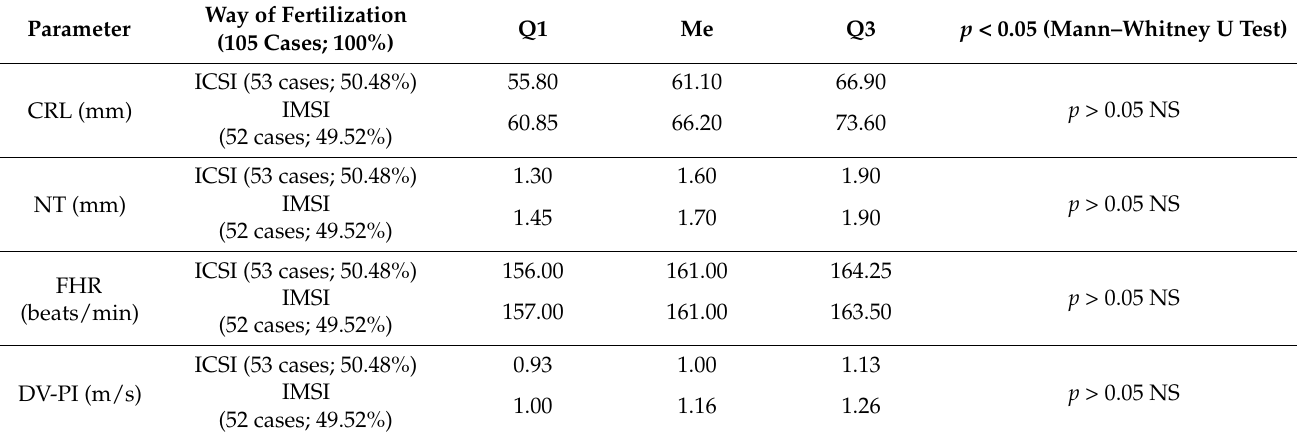
Table 4. Assessment of the parameters describing the growth and health of the fetus without a congenital heart defect based on ultrasound examination in a group of women who became pregnant as a result of the Intracytoplasmic Sperm Injection technique or the Injection of Morphologically Selected Sperm.